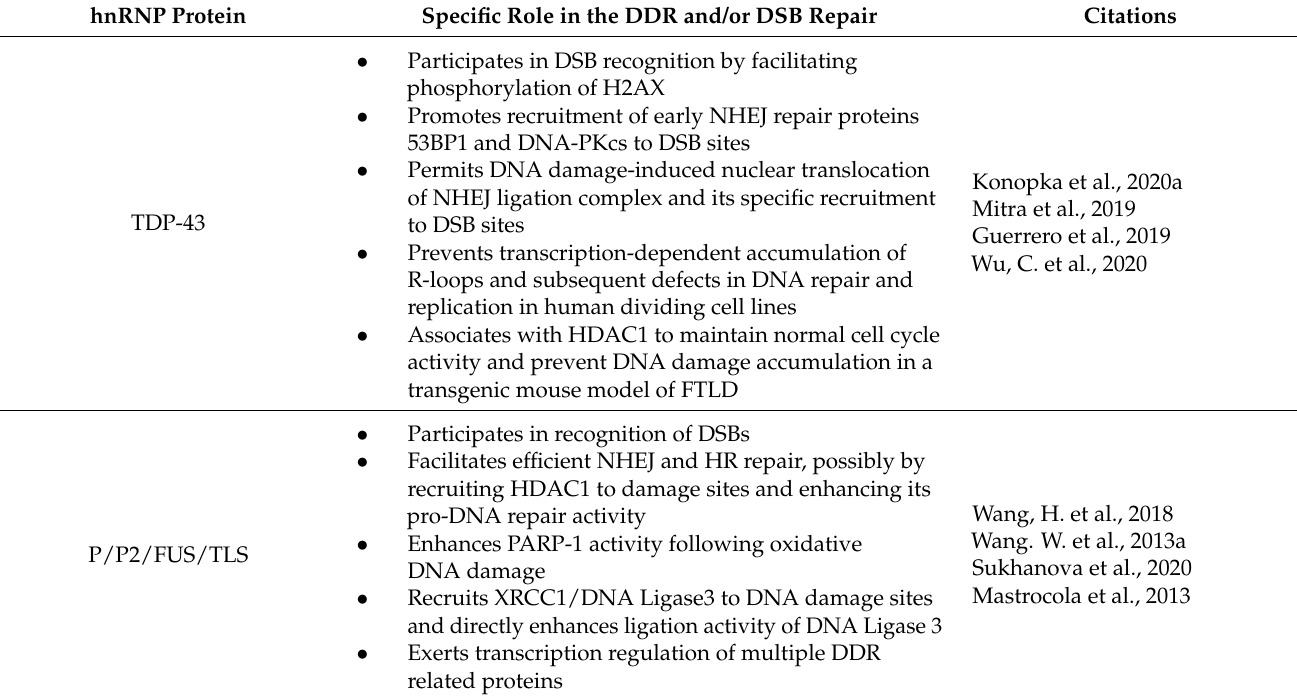
Figure 1. Summary of hnRNP Functions in DNA repair. Most hnRNP proteins exhibit significant functional overlap across the major SSB and DSB repair pathways in addition to damage-induced signaling cascades mediated by upstream ATM and ATR kinases. Specific functions of each protein are detailed in Table 1. MMEJ is an alternative DSB repair pathway important to neuron genome stability (not shown). hnRNP proteins are indicated by dark red text boxes and identified by their named letter (e.g., hnRNP-K is represented by “K”) or initialism. Other repair factors are presented in blue. Created with BioRender.com. Table 1. Summary of hnRNP Roles in genome maintenance.